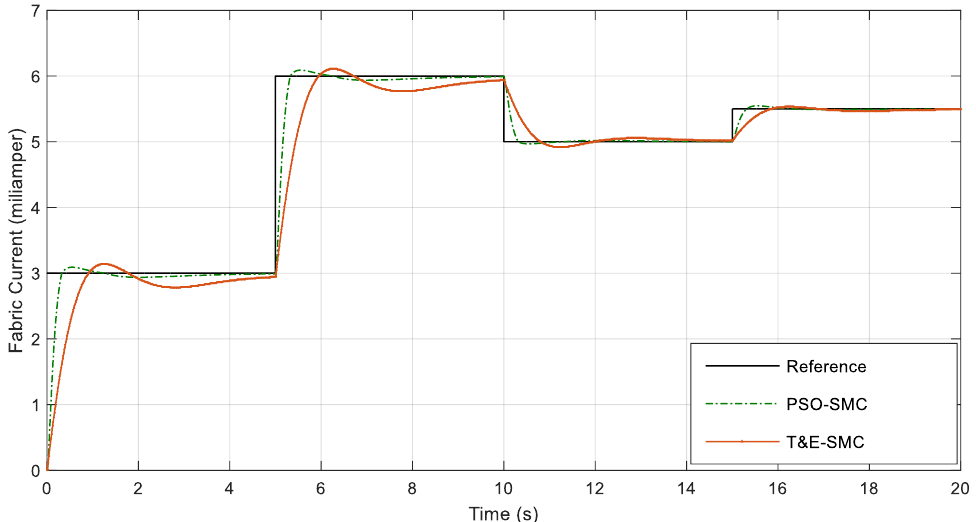
Figure 10. Fabric current based on the scenarios in Table 1.